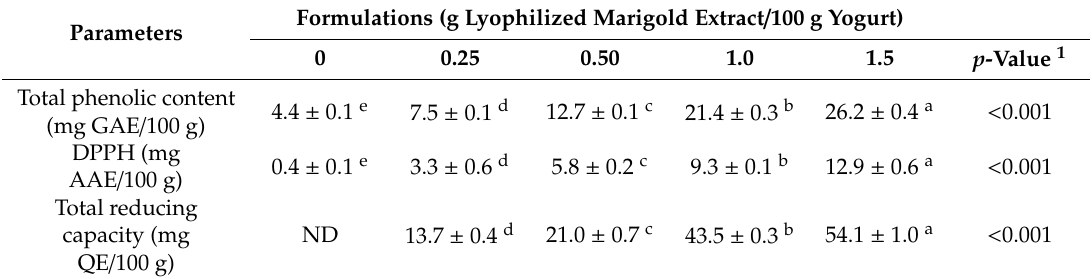
Table 6. Total phenolic content and chemical antioxidant activity of organic yogurt with di ff erent concentrations of lyophilized marigold extract ( C. o ffi cinalis